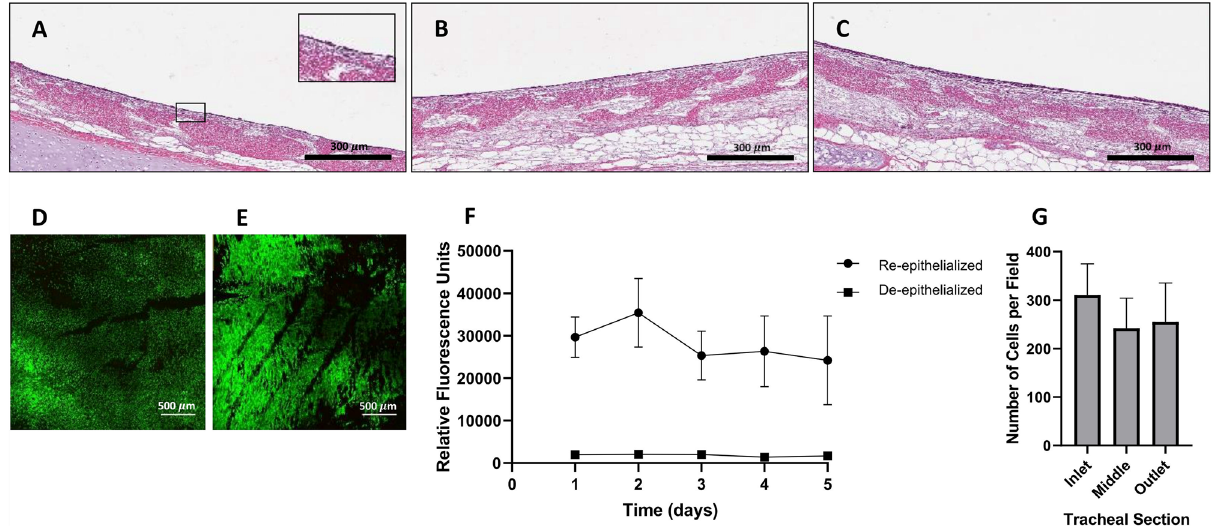
Figure 6. Long-term re-epithelialization of de-epithelialized tracheal grafts at 1 rpm in the single rotating inlet bioreactor. ( A – C ) H&E staining of the inlet ( A ), middle ( B ), and outlet ( C ) sections. ( D , E )